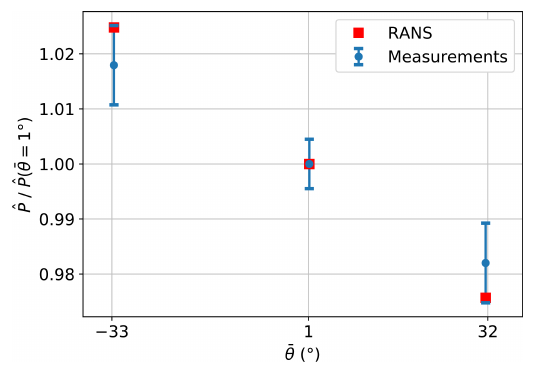
Figure 11. Normalised power output variation with wind direction based on measurements and simulations. Error bars represent 95% confidence